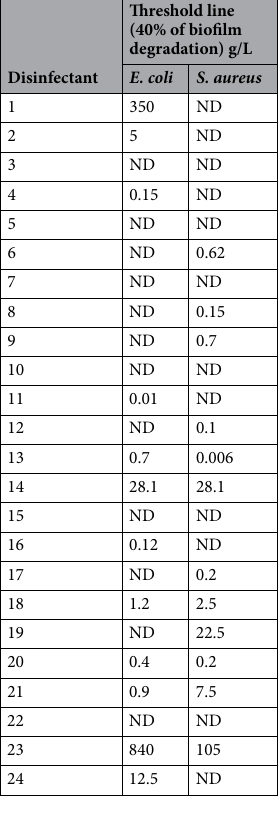
Table 3. Biofilm degradation activity of 24 disinfectants against E. coli and S.